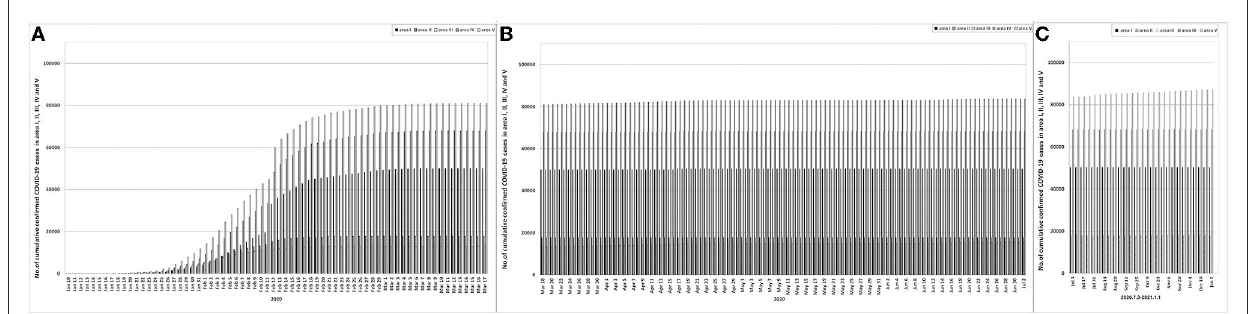
FIGURE3 (A–C) Cumulative COVID-19 cases updated daily (or weekly) in areas I, II, III, IV, and V. The data before July 3, 2020 was updated once a day, and the data after July 3, 2020 was updated once a week. Area I, Wuhan city. Area II, Hubei province (excluding Wuhan city). Area III, Chinese mainland (excluding Hubei province). Area IV, Hubei province (including Wuhan city). Area V, Chinese mainland (including Hubei province). On January 12, 2020, the sudden increase of confirmed cases was related to the clinical cases (Nucleic acid undetected) from Hubei province (including